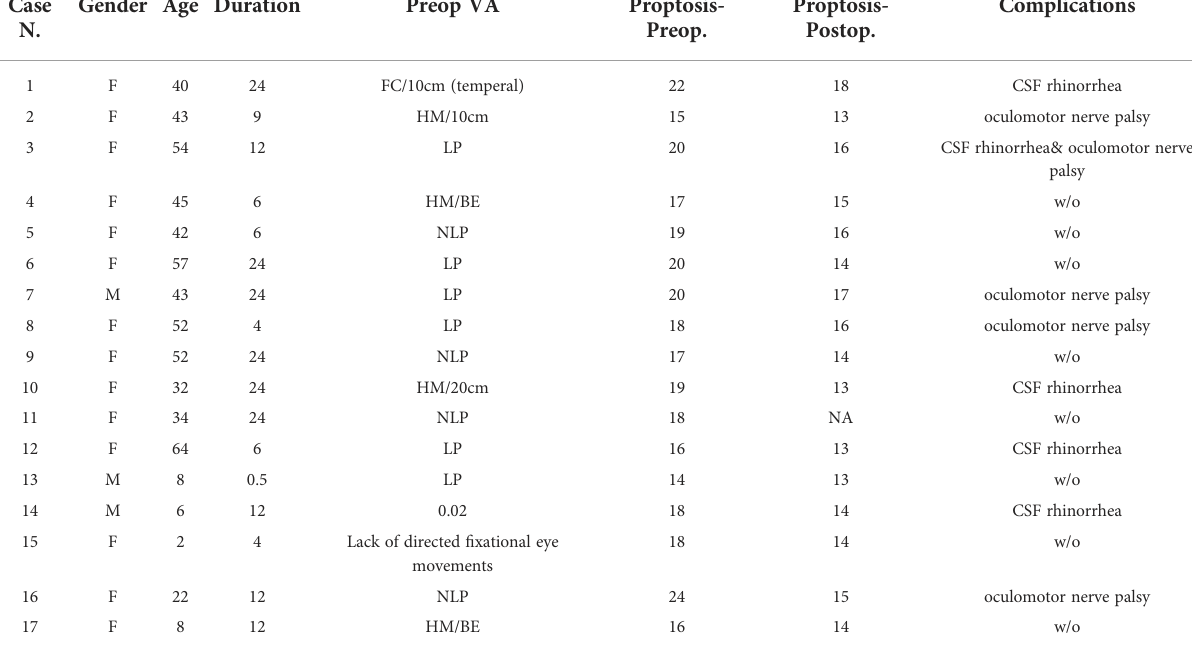
TABLE 1 Clinical characteristics of patients. Case